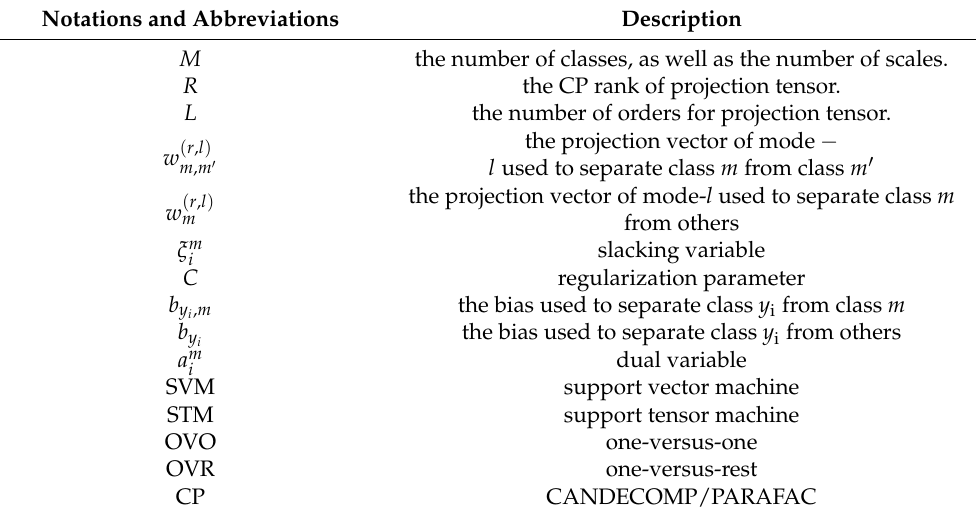
Table 2. The description of notations and abbreviations for the proposed MCMS-STM. Notations and